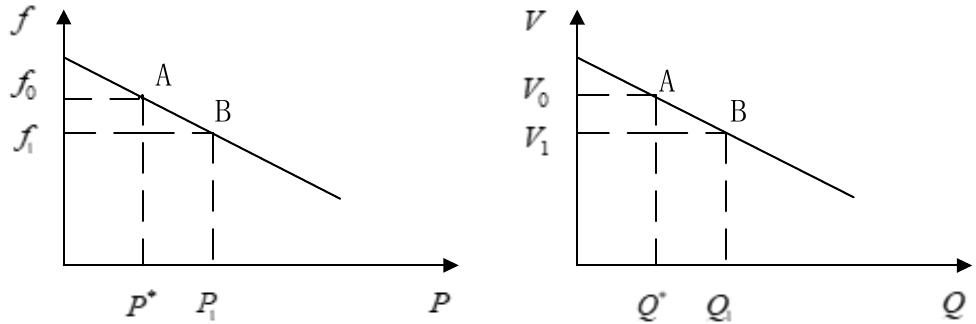
Figure 3. Droop control characteristic curve. A represents rated power and moves to point B when the system load increases.